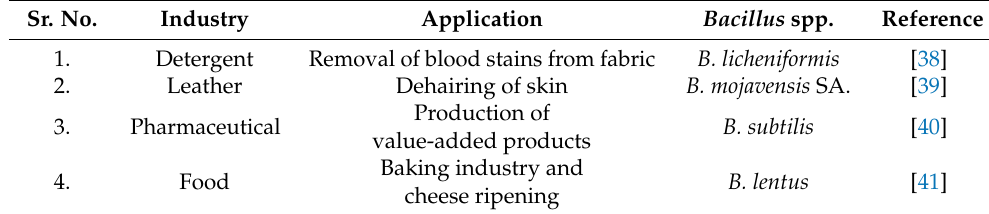
Table 2. Current research trends and industrial applications of proteases secreted from Bacillus spp. Sr.